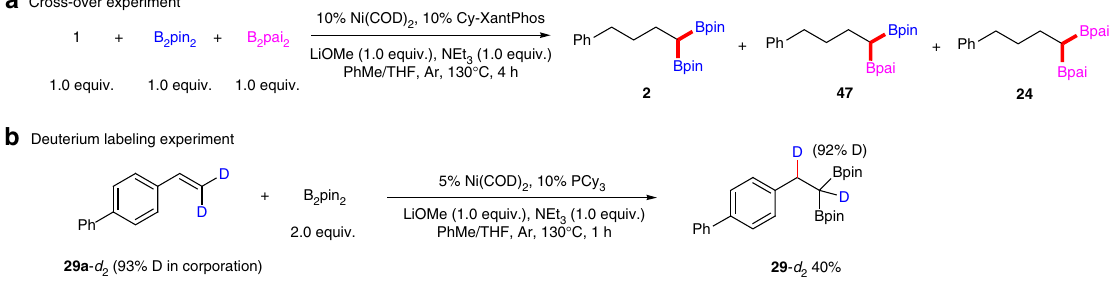
Fig. 3 Mechanism study experiments. a Cross-over experiments of 1 with B 2 pin 2 and B 2 pai 2 to afford 1,1-diboron compounds 2 , 47 and 24 respectively. GC peak area ratio of 2 , 47 , 24 is 1/2.2/1.1 (Correction factor is not taken into account). b Deuterium labeling experiment was conducted using 29a - d 2 as starting transformations and even enantioselective catalytic cross-coupling reactions. Novel reactions of 1,1-diborylalkanes